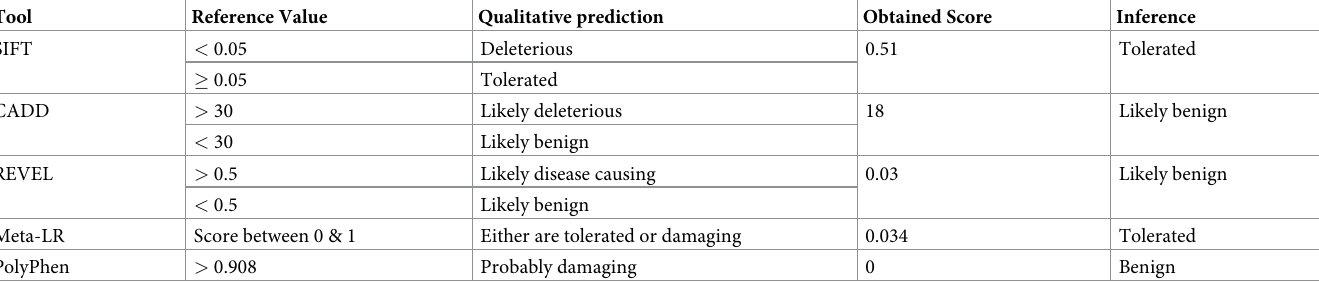
Table 3. TGF- β 1 +29C/T variant as predicted by SIFT, CADD, REVEL, PolyPhen and MetaLR tools. Tool